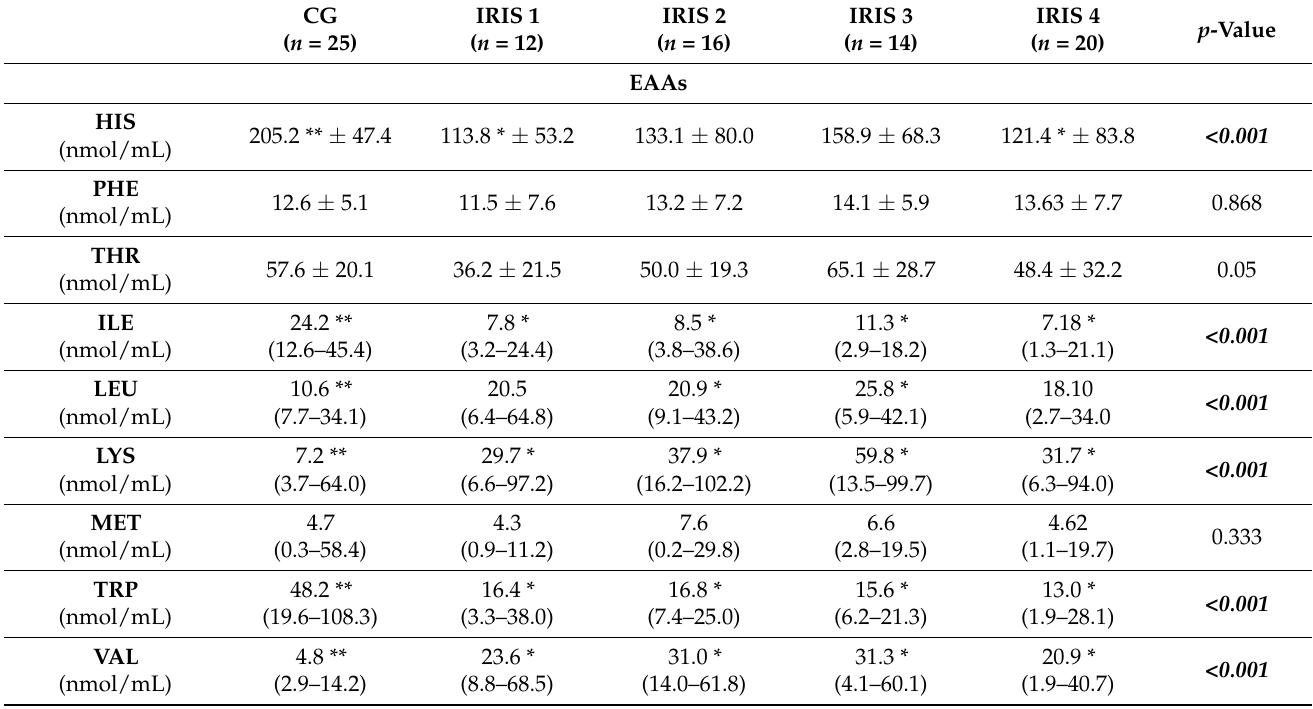
Table 2. One-way ANOVA and Kruskal–Wallis comparisons of serum amino acids of dogs of the control group and dogs at different stages of chronic kidney